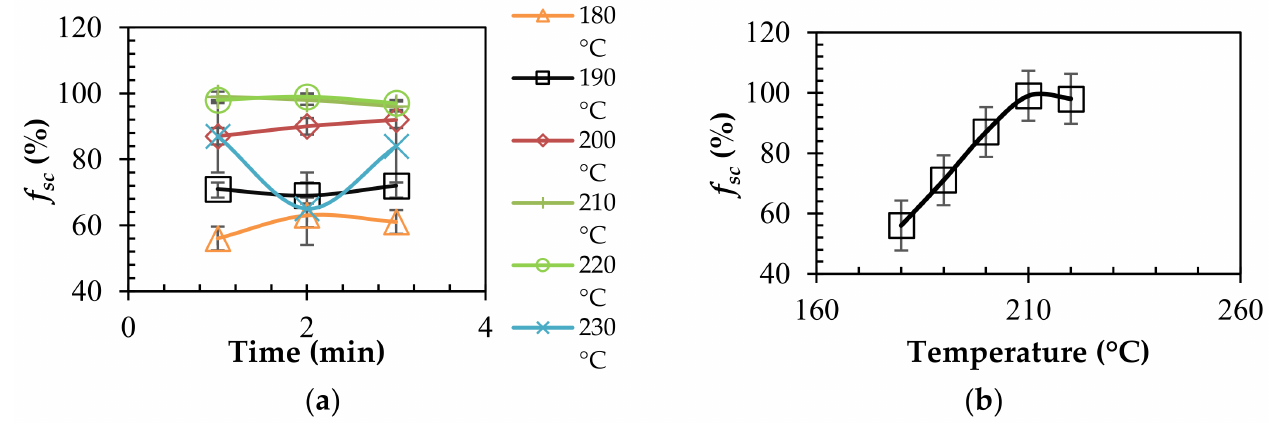
Figure 7. ( a ) Isothermal stereocomplexation kinetics. ( b ) Effect of temperature on stereocomplex